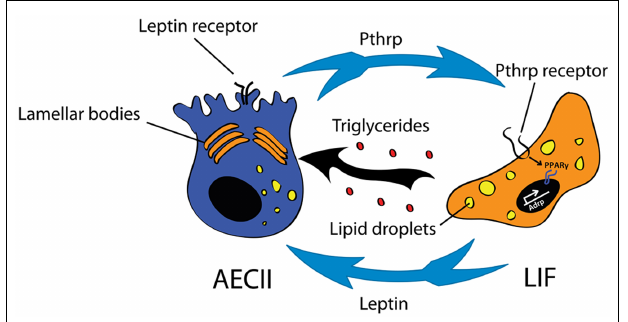
FIGURE 3 | Interaction between type II alveolar epithelial cells (AEC II) and lipofibroblasts (LIF) for surfactant production . The Pthrp (parathyroid hormone-related protein)/Pparg (peroxisome proliferator-activated receptor gamma) axis is important for LIF formation and maintenance. LIF secrete triglycerides and leptin that are essential for surfactant